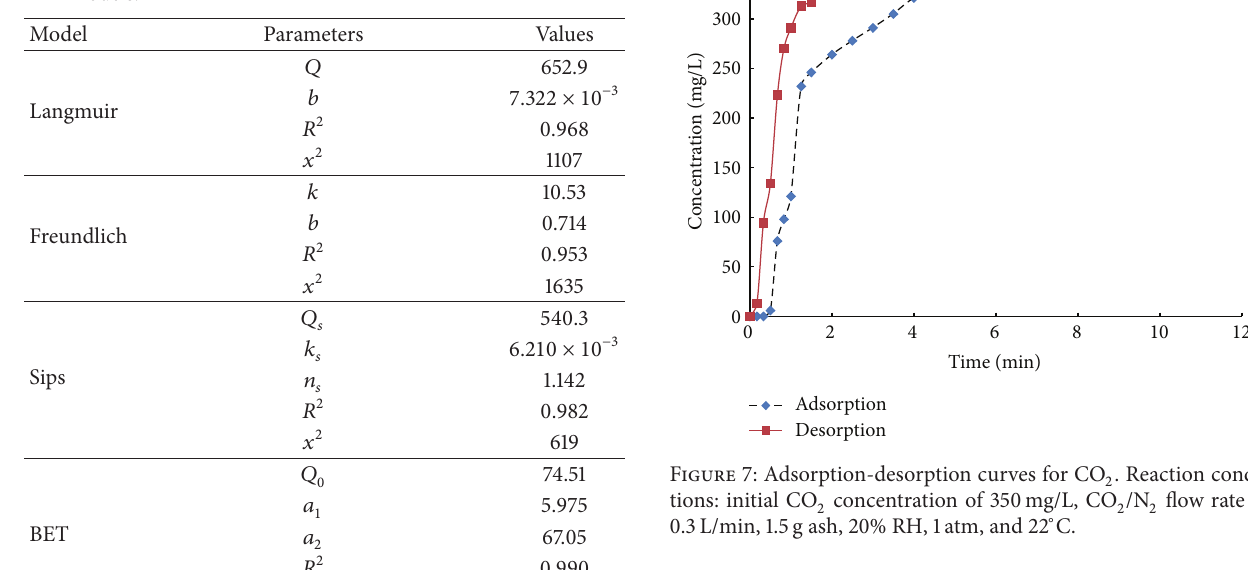
Table 3: Isotherm parameters for the Langmuir, Freundlich, and BET models.